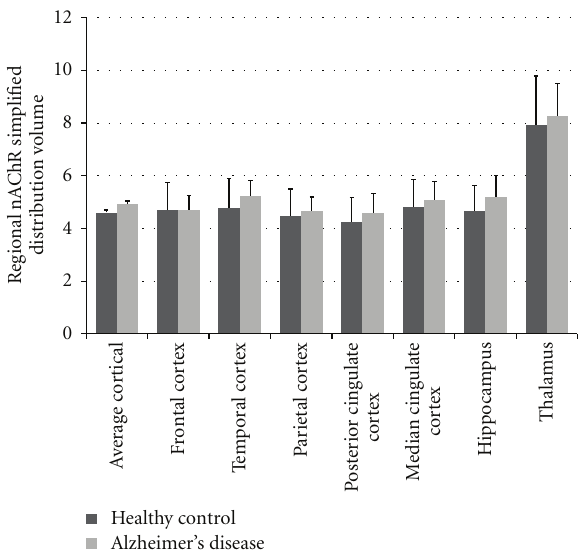
Figure 5: Regional nAChR simplified distribution volume (DV(s)) of 2-[ 18 F]F-A85380 in healthy control (HC) and Alzheimer’s disease (AD) groups. No significant di ff erence in nAChR DV(s) was found between both groups. (Data is from the paper of Ellis et al.